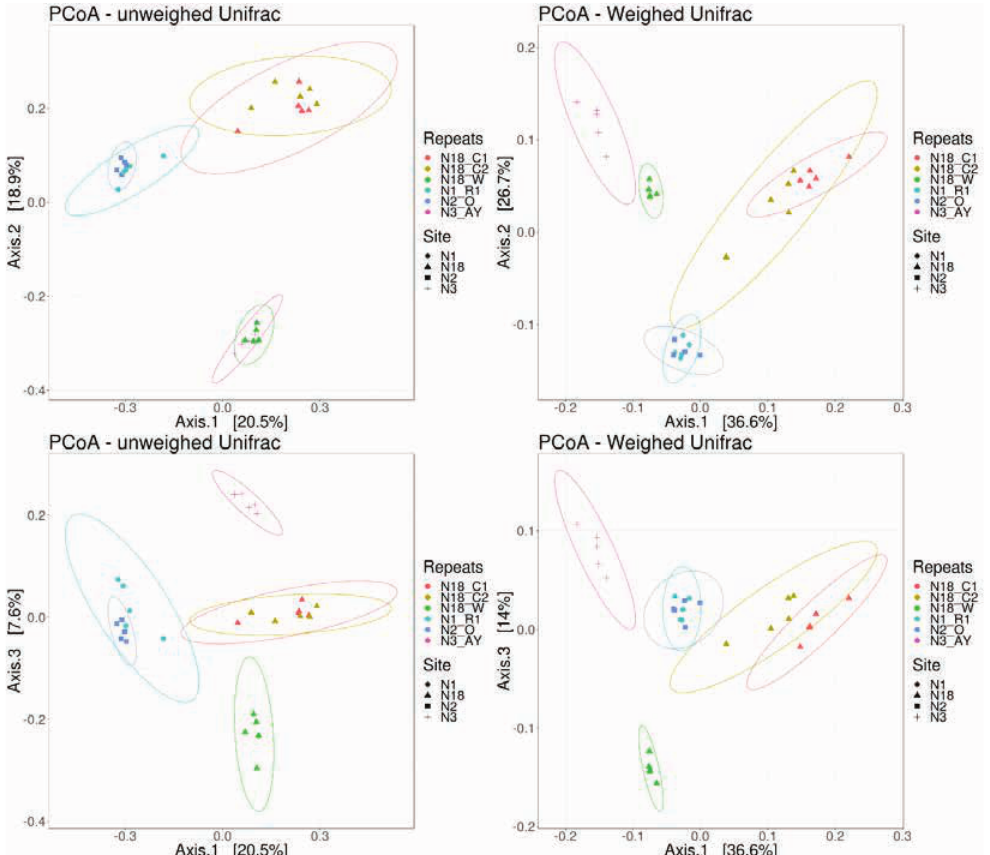
Figure 4: Beta diversity assessed by weighted and unweighted unifrac. PCoA for axis 1-2 and 1-3 are shown to see different